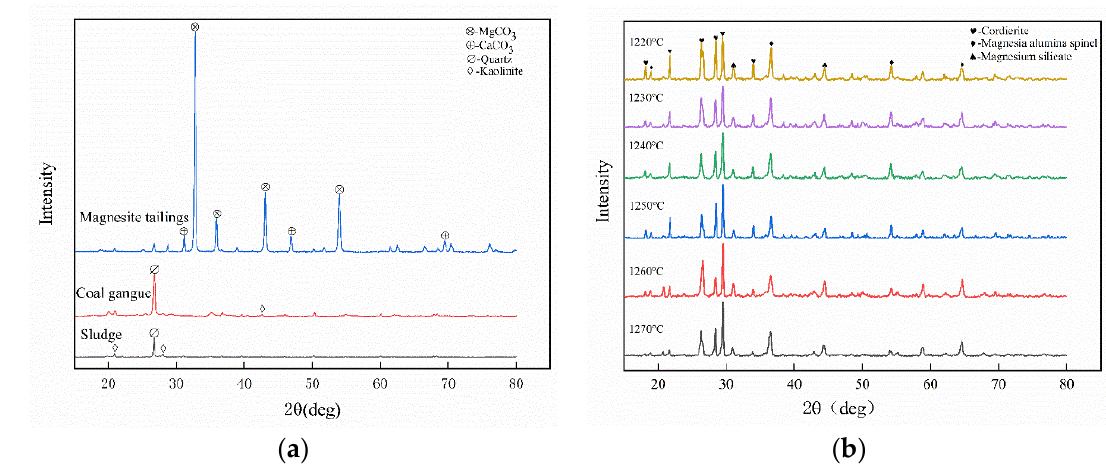
Figure 5. XRD patterns of raw materials and ceramsites at different sintering temperatures: ( a ) MTs,